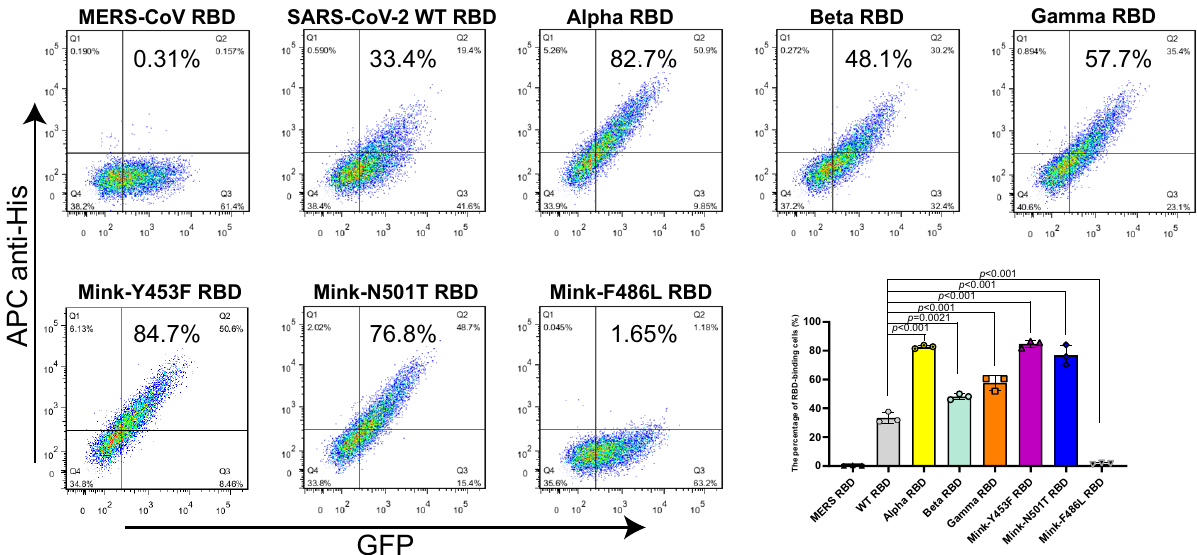
Fig. 1 Characterization of binding between different RBDs and hACE2 using fl ow cytometry. BHK cells stably expressing GFP and hACE2 were incubated with His-tagged MERS-CoV RBD, SARS-CoV-2 WT RBD, Alpha RBD, Beta RBD, Gamma RBD, Mink-Y453F RBD, Mink-N501T RBD, and Mink-F486L RBD, respectively. APC anti-His antibodies were used to detect the His-tagged protein binding to the cells. Representative results from three experiments are shown. The mean ± SD percentages of RBD-binding cells in the three experiments are shown in the right lower bar chart. Statistical signi fi cance was analyzed using one-way ANOVA with a Tukey ’ s multiple comparison test for multiple